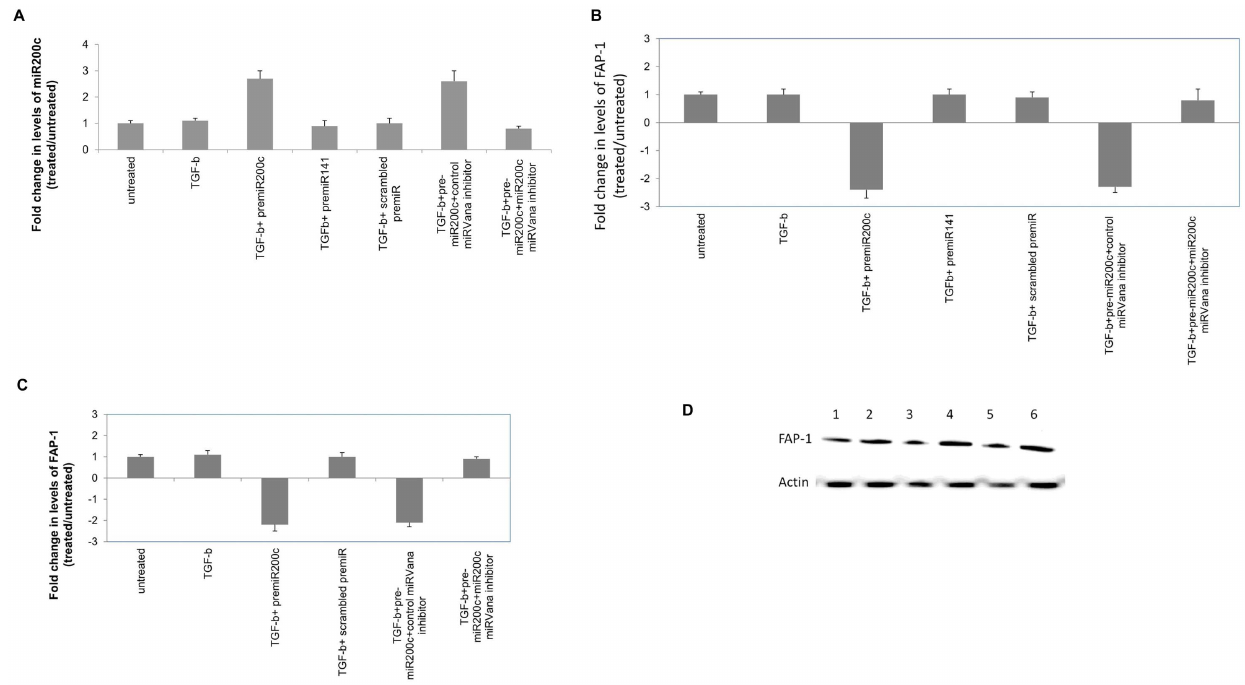
Figure 4. Increased miR200c decreases FAP-1 expression. Human liver fibroblasts were transfected with pre-miR200c miRNA or scrambled miRNA (200 nM) using Lipofectamine RNAiMax and stimulated with TGF- b (50 ng/mL). RNA was isolated using trizol reagent and expression levels of miR200c and FAP-1 were measured using pre-developed Taqman miRNA and mRNA assays respectively. The small RNA U6b (miRNA) and GAPDH (mRNA) was used as an endogenous control and relative levels was calculated by the DD Ct method. Bars represent the mean expression observed in 3 different experiments performed with 3 different fibroblasts. In order to further define the role of miR200c, we cotransfected fibroblasts with pre- miR200c and mir Vana H miRNA inhibitor for miR200c and analyzed for the expression levels of miR200c and FAP-1. Cotransfection with mir Vana H miRNA inhibitor (50 nM) resulted in restoration of the levels of miR200c and FAP-1 to the levels observed in the untreated fibroblasts. a) Relative expression levels of miR200c; b: Relative expression levels of FAP-1 at the mRNA level; c: Relative expression levels of FAP-1 at the protein level and d: Representative western blot analysis of FAP-1. Lanes 1) Fibroblasts; 2) Fibroblast + TGF- b ; 3) Fibroblast + TGF- b + pre-miR-miR200c; 4) Fibroblast + TGF- b + scrambled pre-miR; 5) Fibroblast + TGF- b + pre-miR –miR200c + mir Vana H miRNA inhibitor control; and 6) Fibroblast + TGF- b + pre-miR –miR200c + mir Vana H miRNA inhibitor miR200c. fibroblasts with pre-miR200c and stimulated them with TGF- b for 24 hrs. The cells were treated with Src inhibitor-1 (10 m M) or controls during stimulation with TGF- b . Analysis of the FGF levels (4.2 6 0.3 vs 0.8 6 0.3, p . 0.05) in the FGF levels in the miR200c